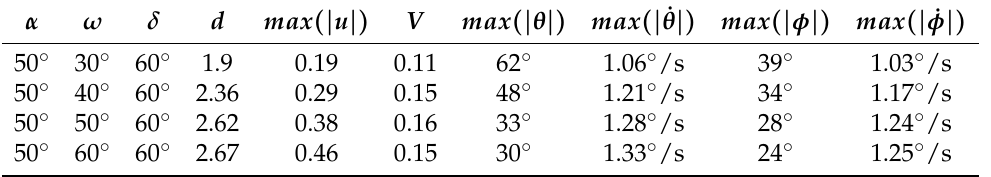
Table 2. Simulation results for different angular frequencies ω .